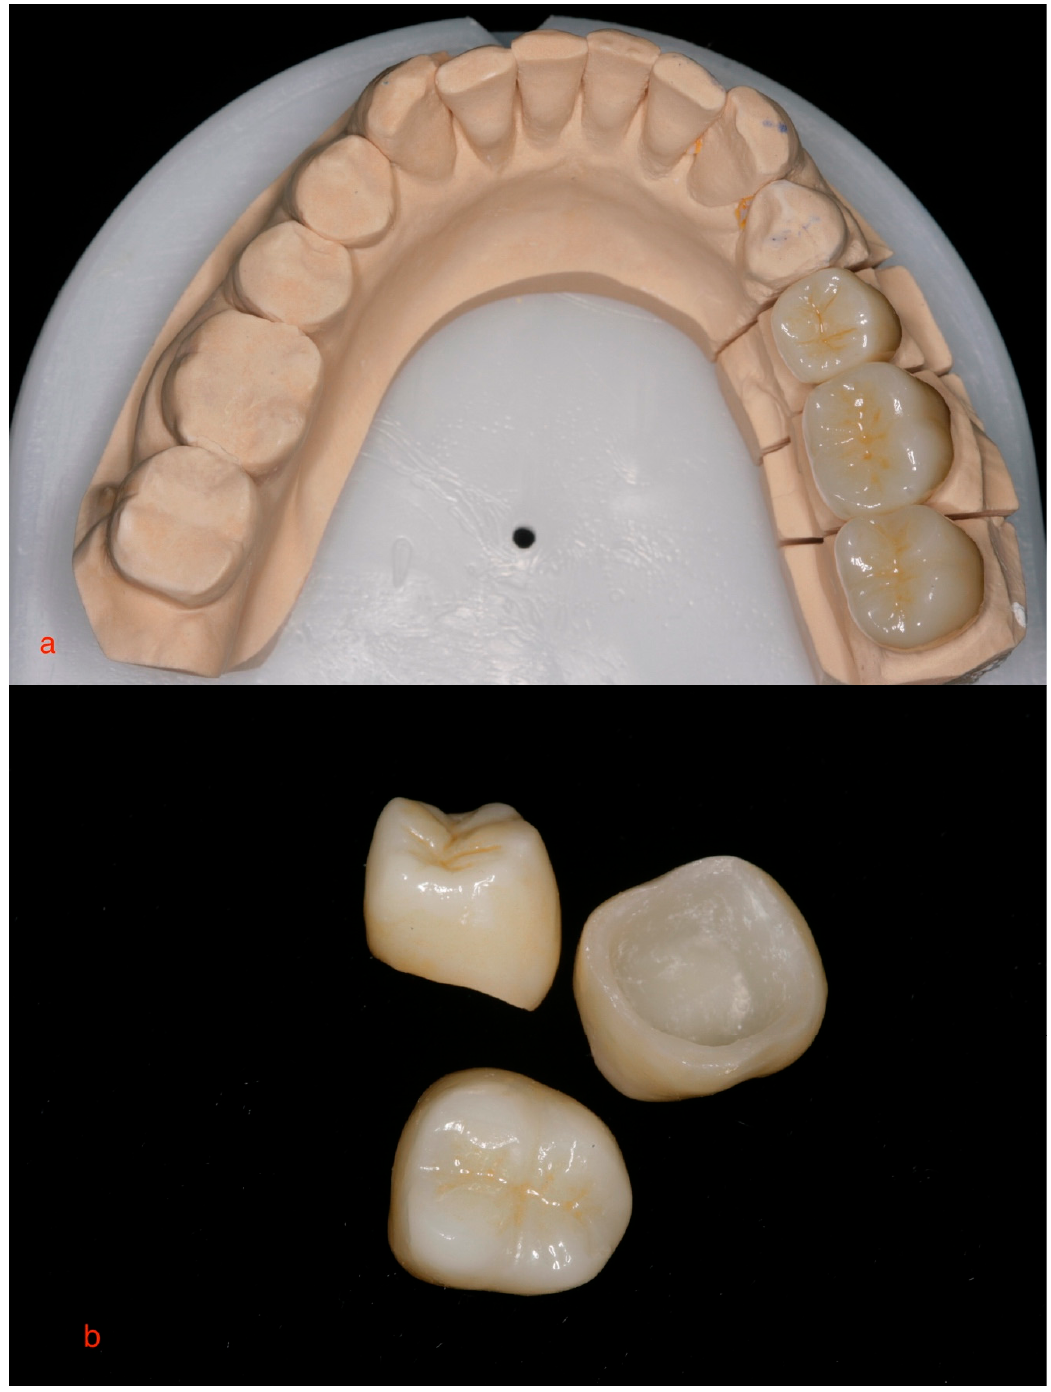
Figure 2. ( a , b ). Final monolithic zirconia crowns with CAD/CAM technology.